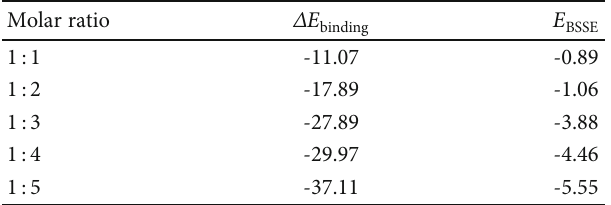
Table 2: The binding energies ( Δ E superposition error (BSSE) of ALA and NVCL in di ff erent imprinted molar ratios at the M06-2X/6-311+G (d, p) level (kJ · mol -1